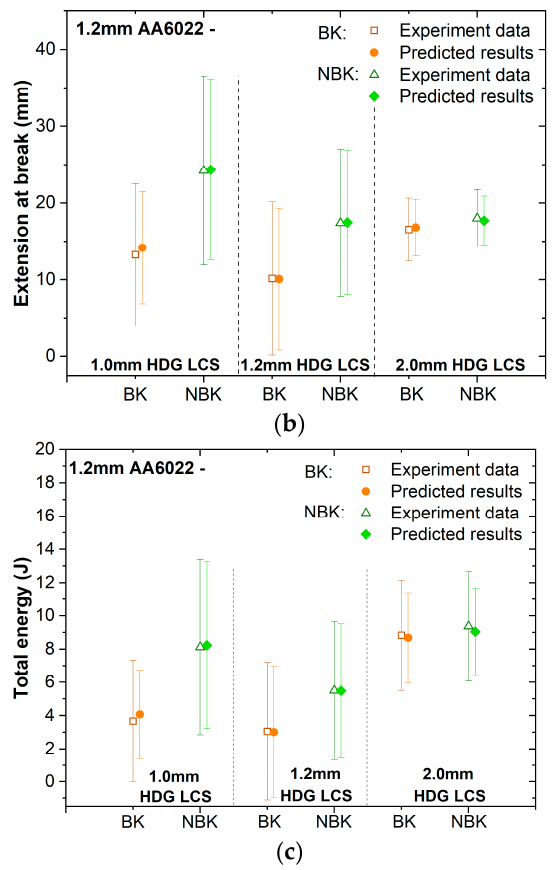
Figure 3. ML analysis illustrated the thickness-dependent baking effect on joint performance of ( a ) peak load, ( b ) extension at break, and ( c ) total energy for dissimilar AA6022-LCS resistance spot welds.